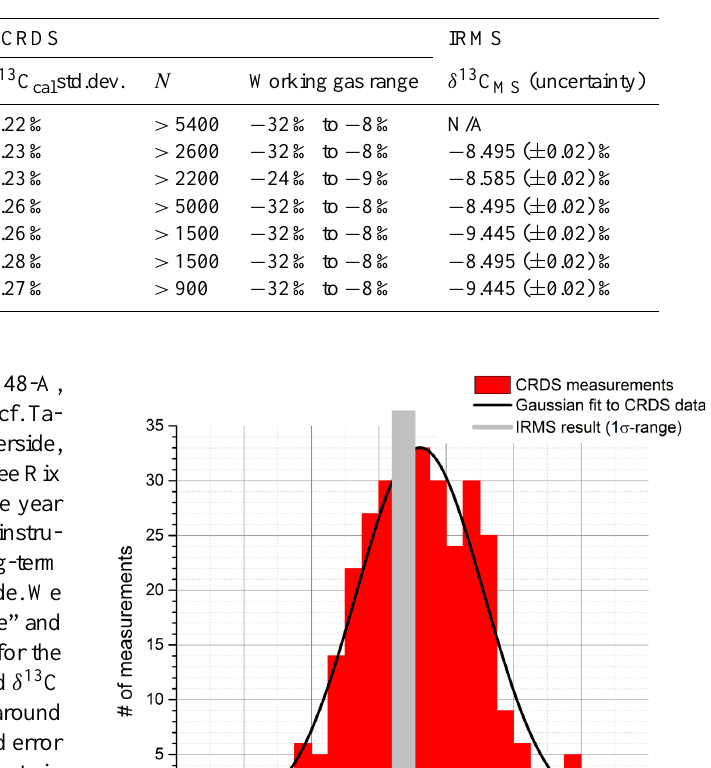
Table 1. Comparison of CRDS and IRMS values of target gas measurements. The standard error for the target measurements of the CRDS ( δ 13 C cal ) are all below 0.01‰, yet the uncertainty is given as ( < 0.1‰) as other sources of error have to be included (see text and cf. Fig. 6).